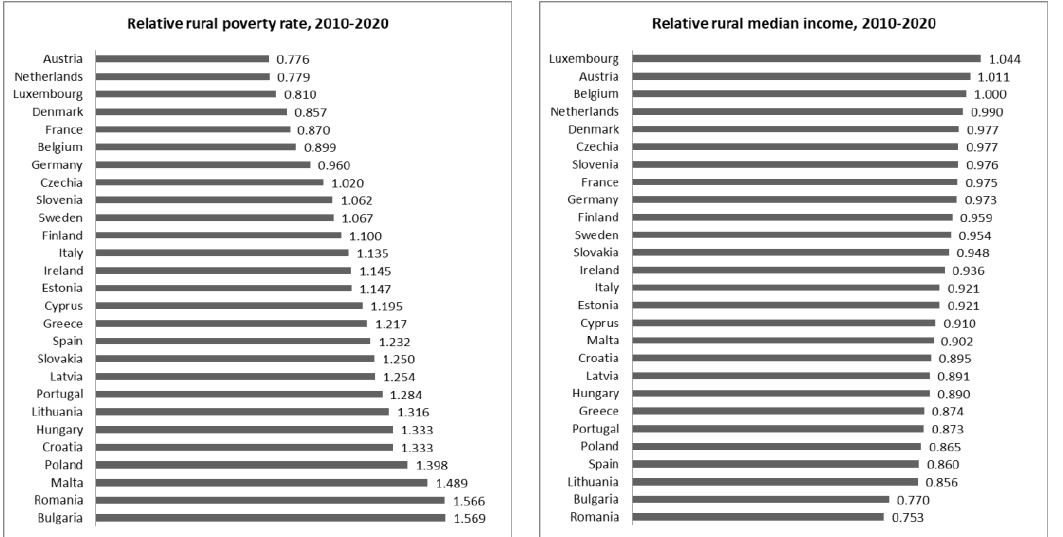
Figure 4. Rural–urban divide across the EU member states. Source: own research based on Eurostat data [91–94].